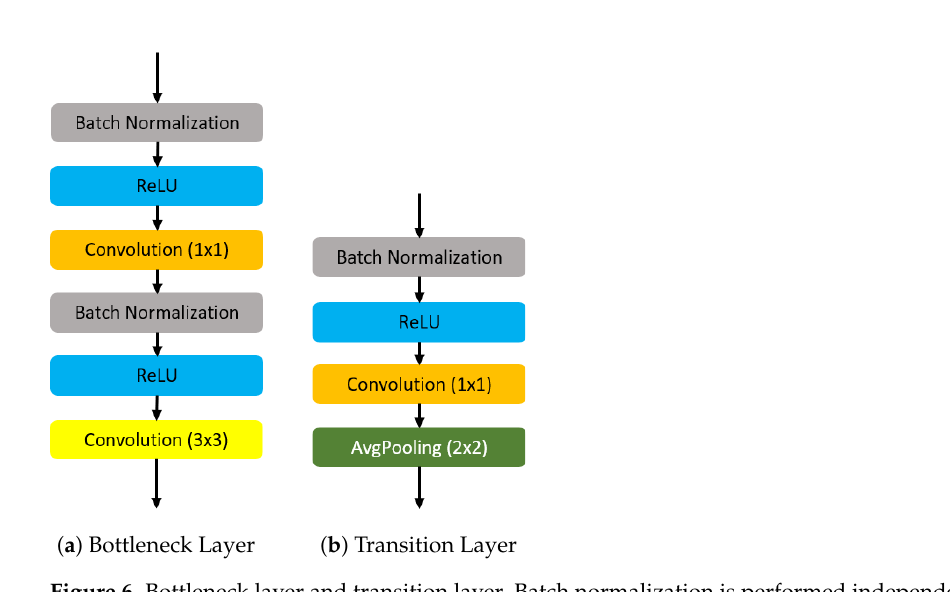
Figure 6. Bottleneck layer and transition layer. Batch normalization is performed independently for each feature map, the ReLU is a piecewise linear function that will output directly if the input is positive; otherwise, it will output zero. As for the 1 × 1 convolution is used to reduce the number of feature maps to improve the computational